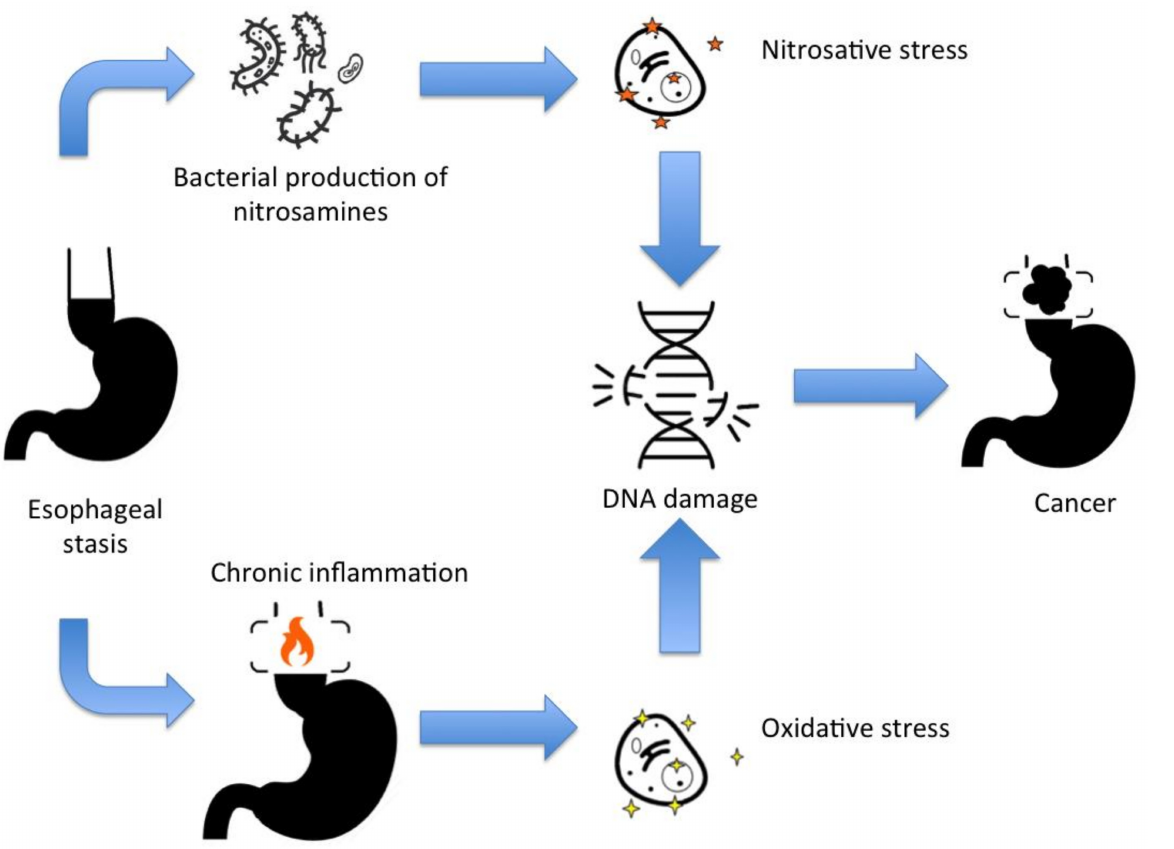
Figure 1. The main mechanisms for DNA damage and cancer development in